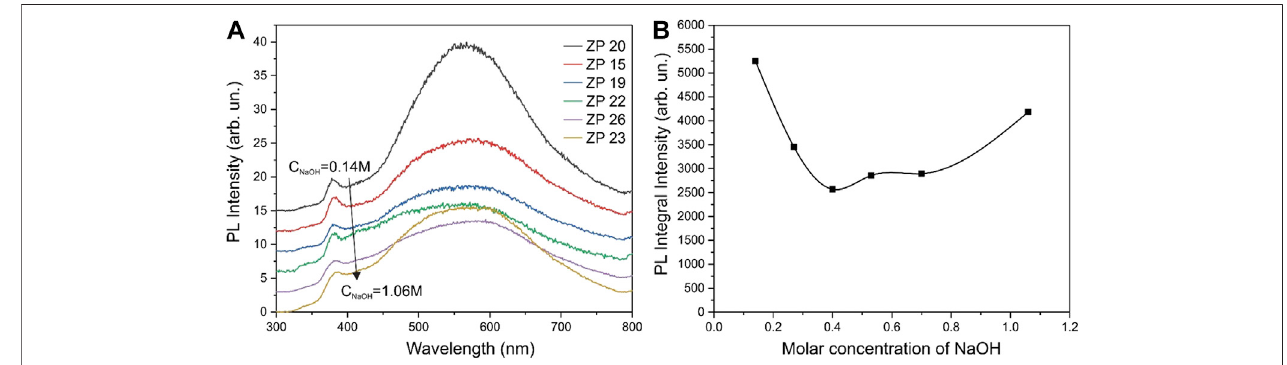
FIGURE 9 | PL spectra of the synthesized ZnO samples taken at room temperature with excitation at a wavelength of 300 nm (A) and the dependence of the integrated PL for the same samples on the molar concentration of NaOH in the growth solution (B) .